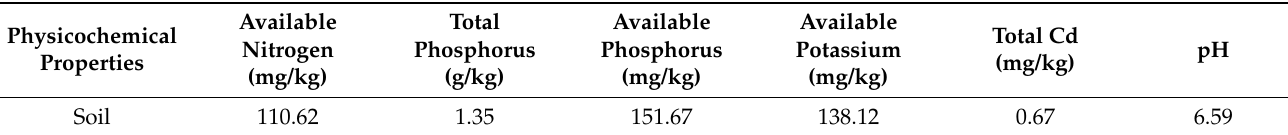
Table 1. Soil physical and chemical properties of experimental field.